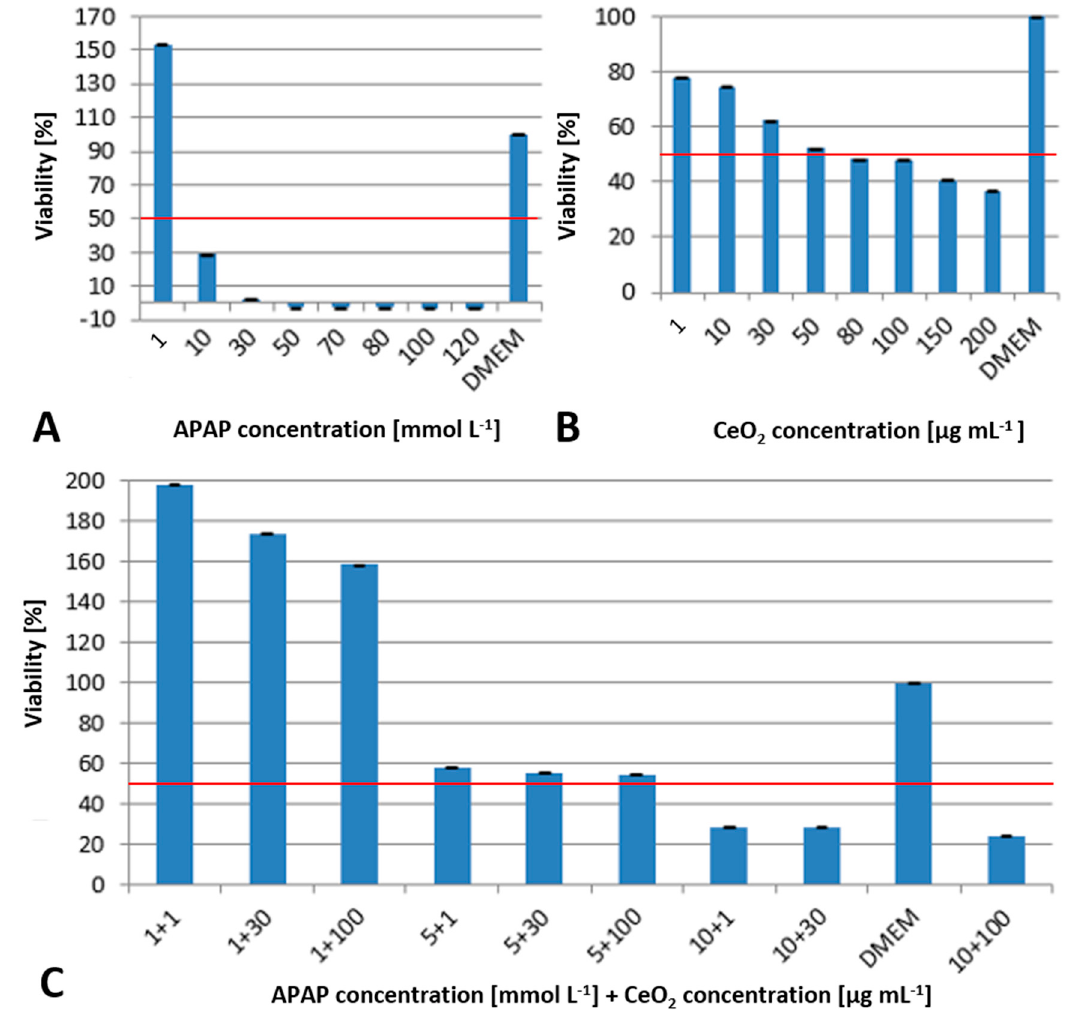
Figure 3. Results of the WST-1 assay after 48 h exposure of HuH-7 cells to APAP ( A ), CeO 2 NPs ( B ) and both in combination ( C ) at different concentrations ± standard deviation normalized to negative control (DMEM) and positive control (TritonX). Red line indicates the EC50. All tests with one biological and six technical replicates.